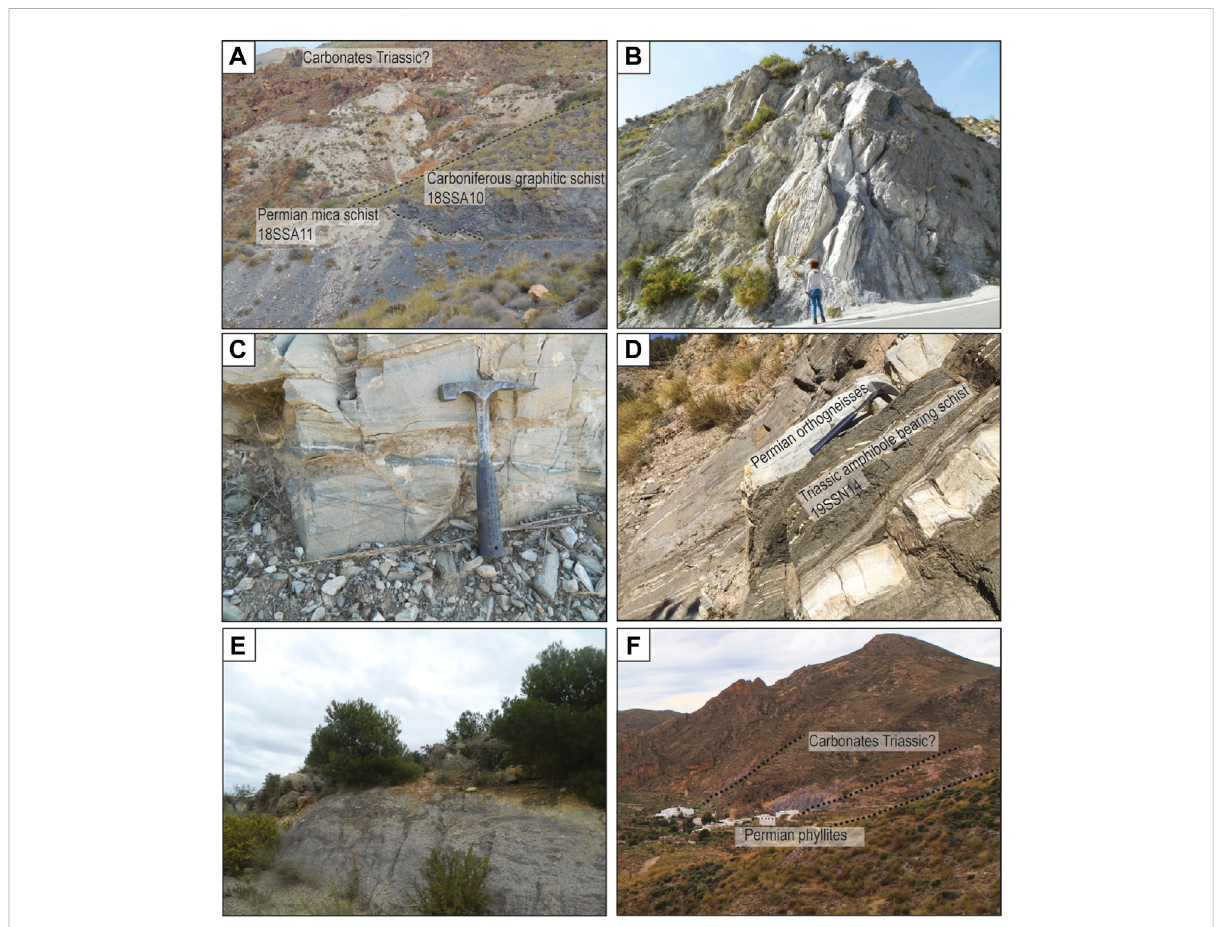
FIGURE 7 (A) Outcrop in Sierra Alhamilla from the Alpujárride Complex, showing Permian mica schist overlaying the Carboniferous graphitic schist. (B) Talc/serpentinite outcrop marking the contact between the NFC and Alpujárride in south Sierra Nevada. (C) Permian metasandstone from south Sierra deLos Filabres possibly preserving cross-bedded strata from initial deposition. (D) Permian orthogneiss overlaying the Triassic amphibolite on West Sierra Nevada. (E) Carboniferous graphitic mica schist underlaying carbonates in the middle Sierra Alhamilla. (F) Outcrop of East Sierra Alhamilla from the Alpujárride complex showing thrust sheets of Permian phyllites with overlaying Triassic (?)